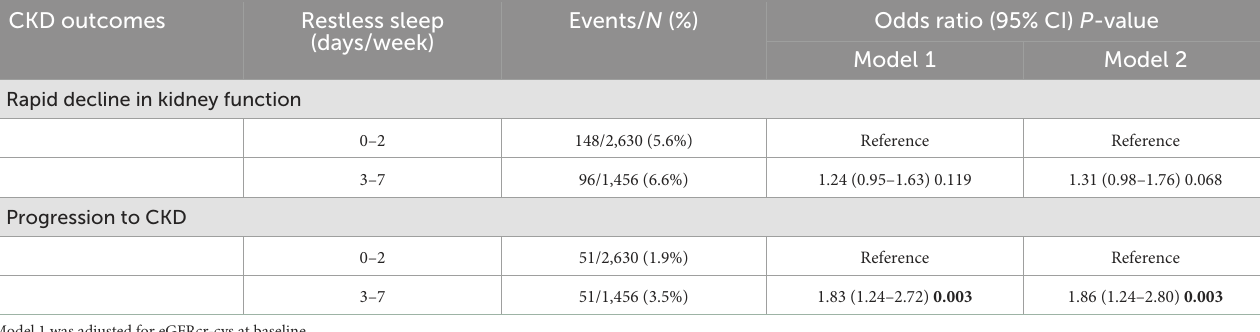
TABLE 4 The association between sleep quality and CKD